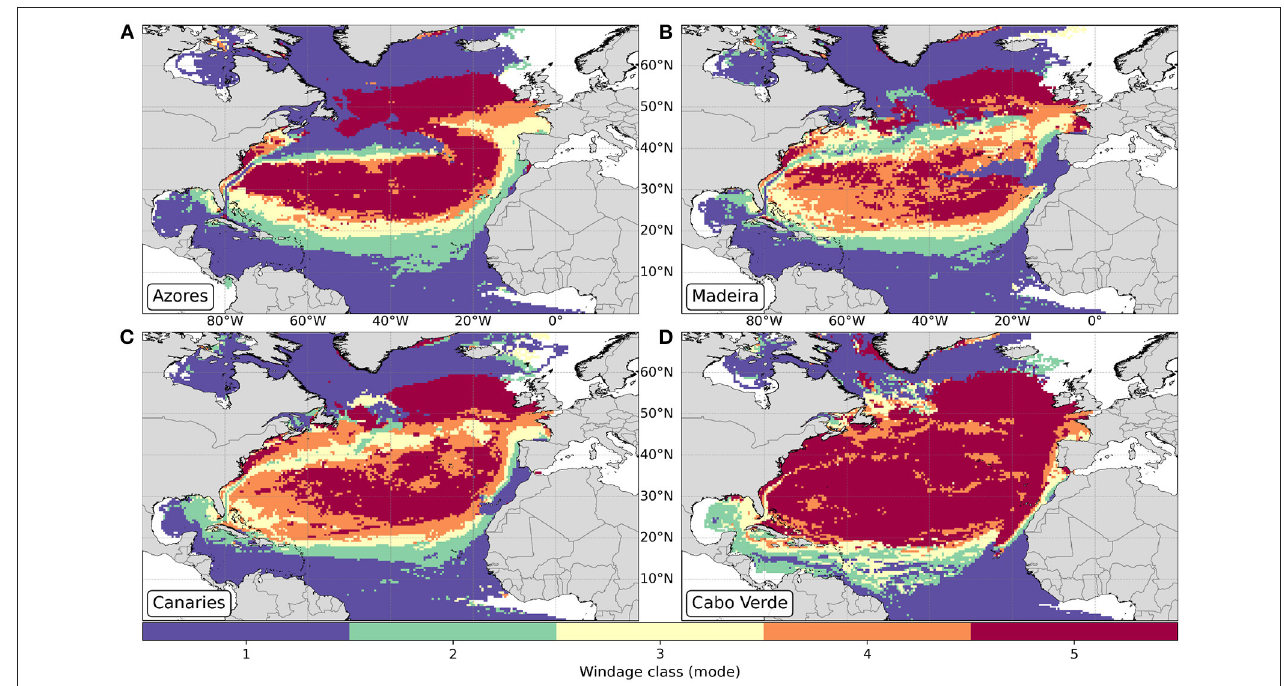
FIGURE 6 | Most frequent occurrence of B surface particle windage class for particles released in the Azores (A) , Madeira (B) , Canaries (C) , and Cabo Verde (D) , detected in 0.5 ◦ grid cells. Windage coefficient values correspond to the percentage contributions of wind forcing at 10 m above sea